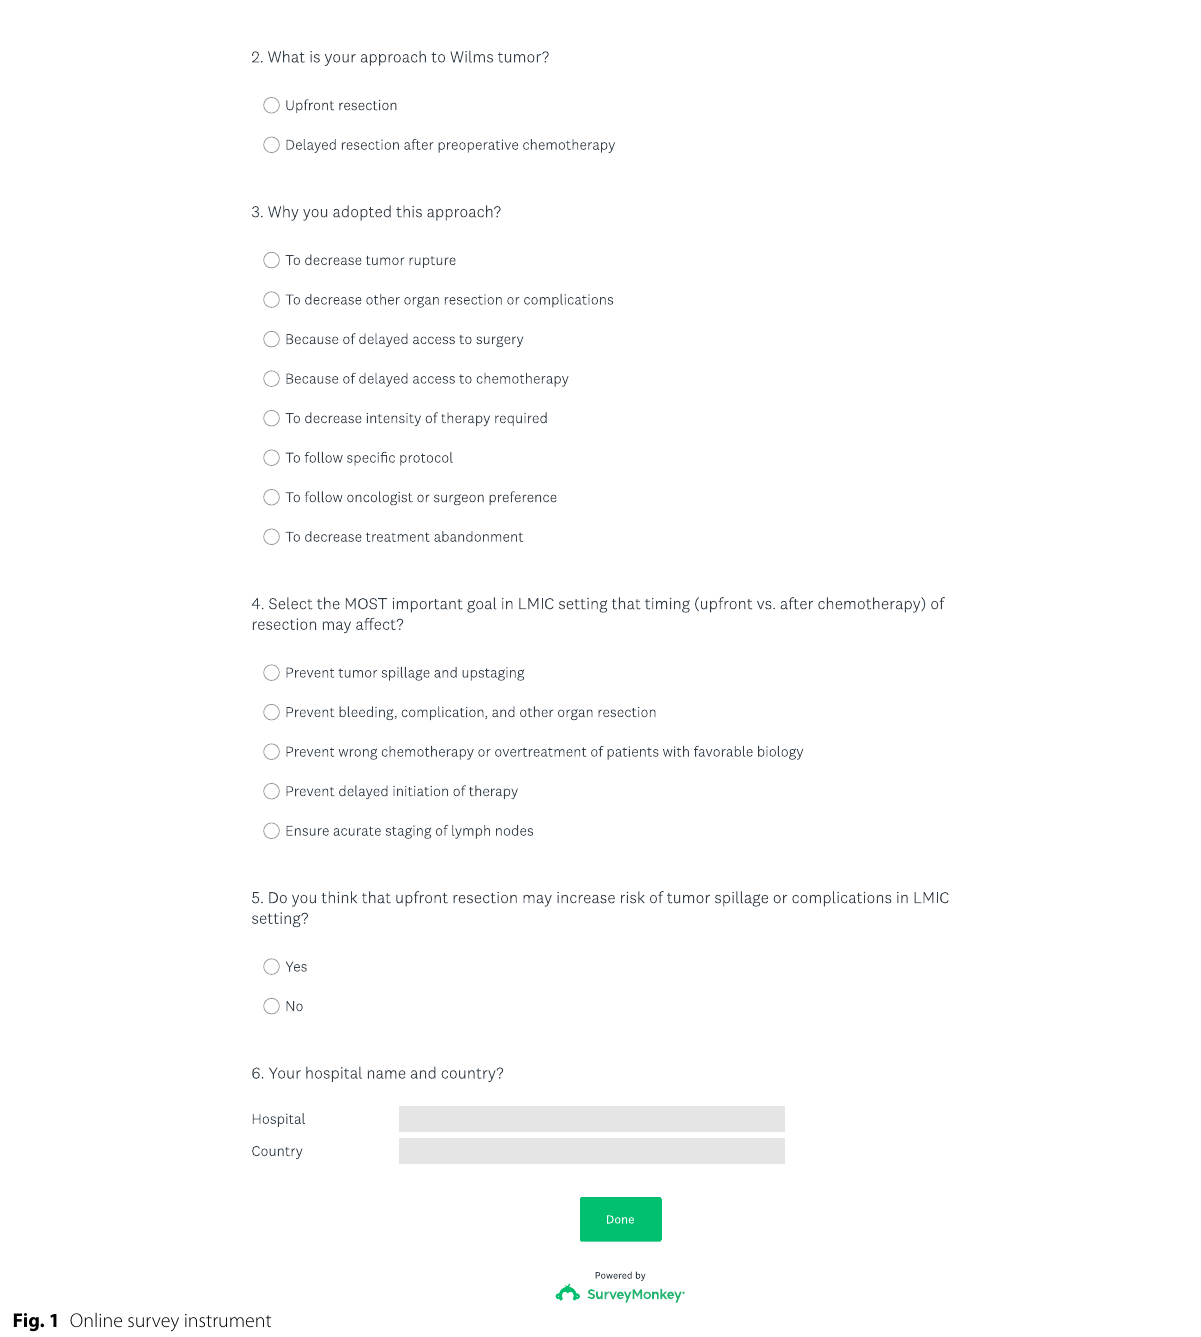
Fig. 1 Online survey